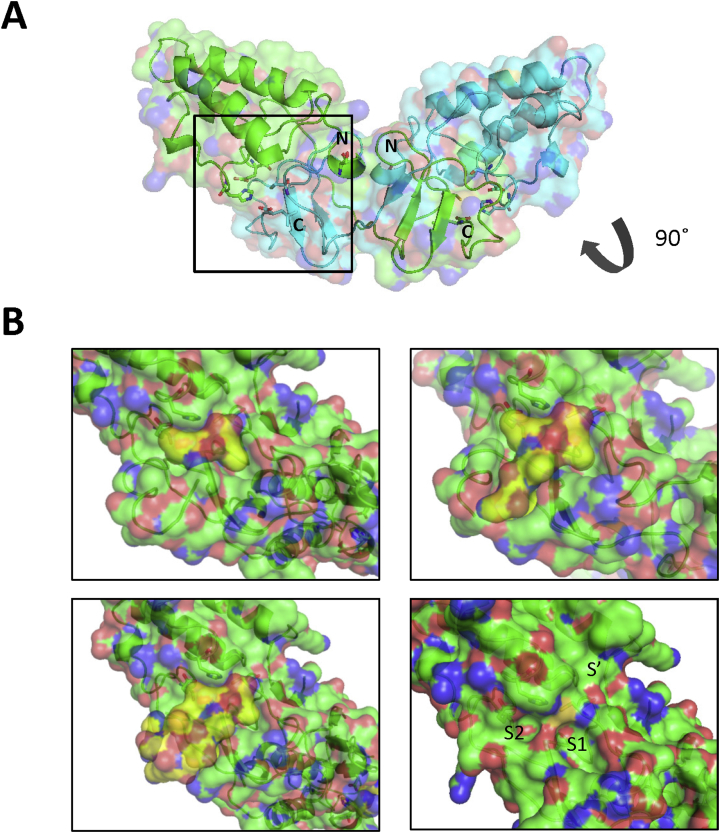
vHTS applied to a model of the NS2 autoprotease active site. Structural coordinates of the post-cleaved NS2 C-terminal domain were obtained from the protein databank (PDB 2HD0). A) The active site (boxed) is present at a dimer interface, with one monomer represented with green carbons and the second monomer with light blue carbons. Nitrogen atoms are shown in dark blue and oxygen atoms in red. N- and C-termini are labelled. B) C-terminal residues were sequentially removed (yellow carbons) to access the active site and produce the models NS2ΔP1−P2 (top left), NS2ΔP1−P5 (top right) and NS2ΔP1−P10 (bottom left). S’, S1 and S2 refer to the binding cavities within the active site for the substrate peptide residues P’, P1 and P2, vHTS targeted S1 and S2 regions of the active site (bottom right).